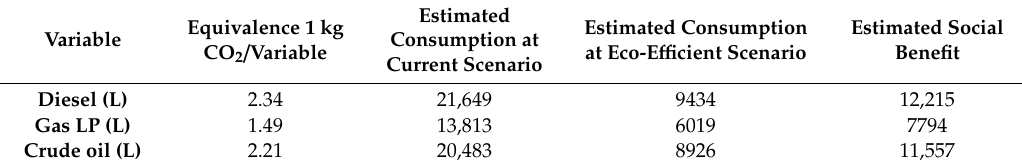
Table 8. Social benefits obtained, comparing both scenarios of egg production in activities equivalent to 1 kg CO 2 eq